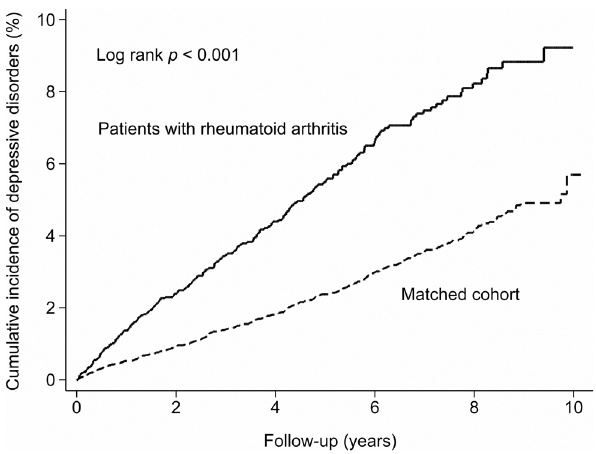
Figure 2. Cumulative incidence of depressive disorders in patients with rheumatoid arthritis (RA) and matched cohort.